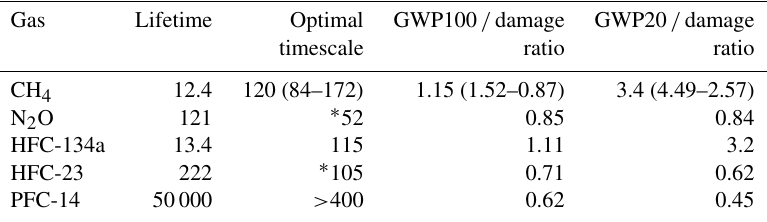
Table 2. Optimal timescale of non-CO 2 gases. Implicit timescale evaluated for non-CO 2 gases with the GWP to damage ratio for the two most common GWP timescales. Asterisks indicate no exact match between GWP ratio and damage ratio; the closest value is given instead. The third and fourth columns show the ratio of the GWP for a given gas to the calculated damage ratio. Interquartile uncertainty ranges are presented for the timescale and damage ratios for CH 4 . The results in this table are derived assuming a discount rate of